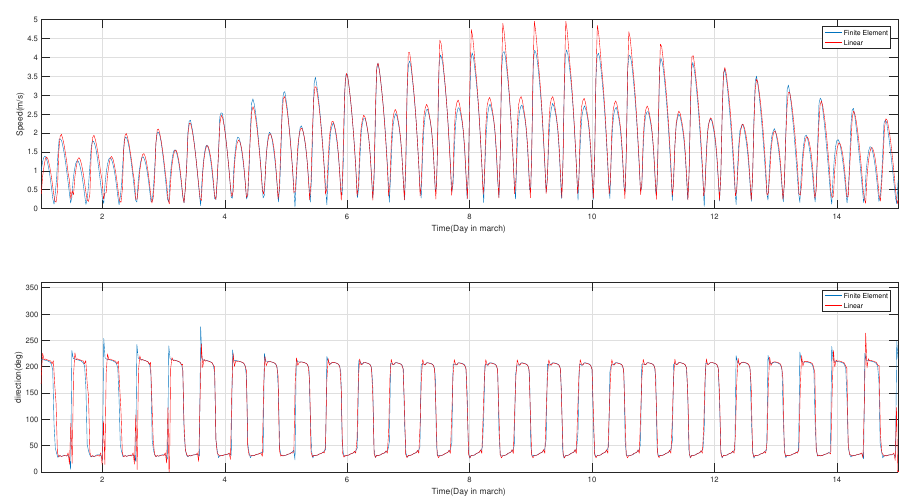
Figure 6. Time series of the predicted depth-averaged amplitude and direction (anticlockwise convention from the east) of the current at point #3 in neap-spring tidal cycle.